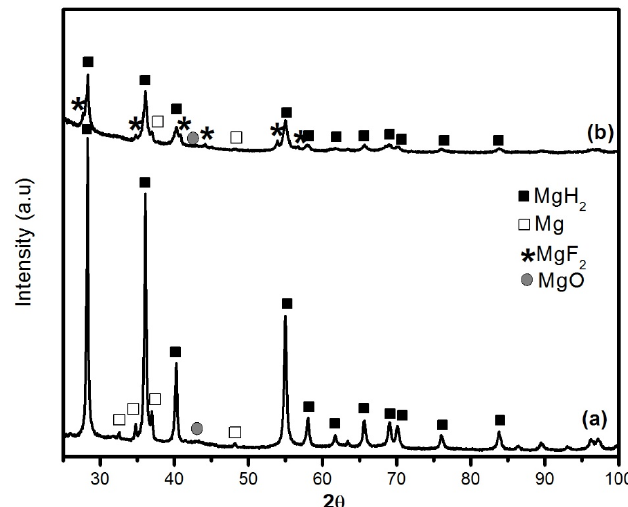
Figure 1. XRD patterns of ball milled samples milled 1 h: ( a ) pure MgH 2 and ( b ) MgH 2 + 5 mol % MgF 2 .